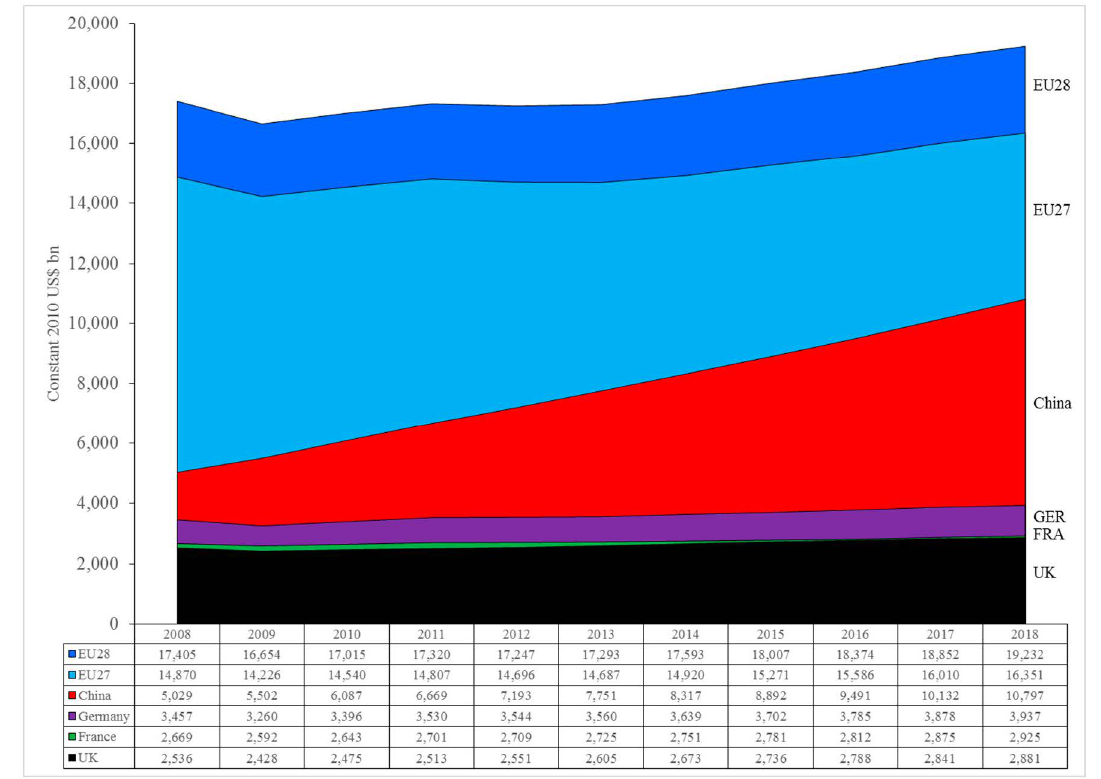
GDP (constant 2010 US$ [billions]), 2008–18. Source: The World Bank, ‘DataBank’ (2020) <http://databank.worldbank.org/data/home.aspx> accessed 27 February